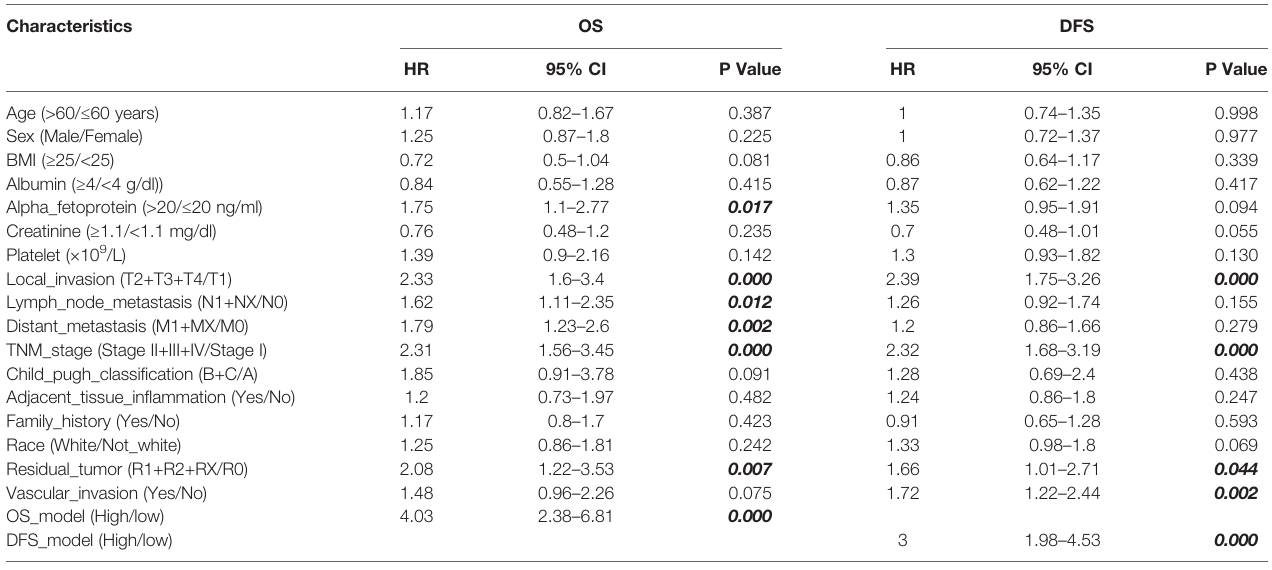
TABLE 1 | Univariate analyses of clinicopathological features for OS and DFS in HCC.